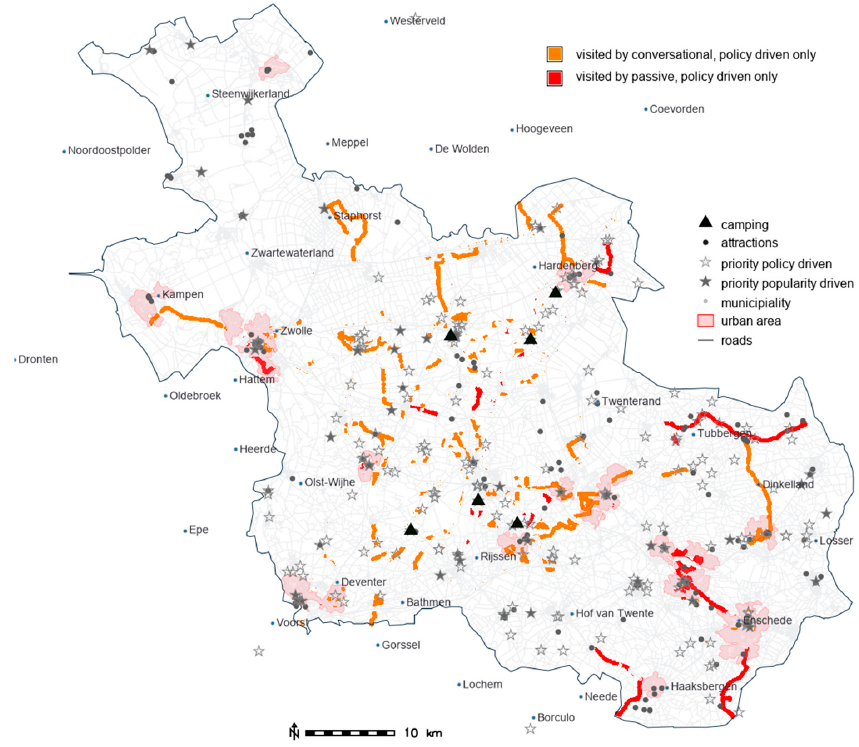
Figure 6. Locations visited exclusively by each of the 2 policy-driven groups.